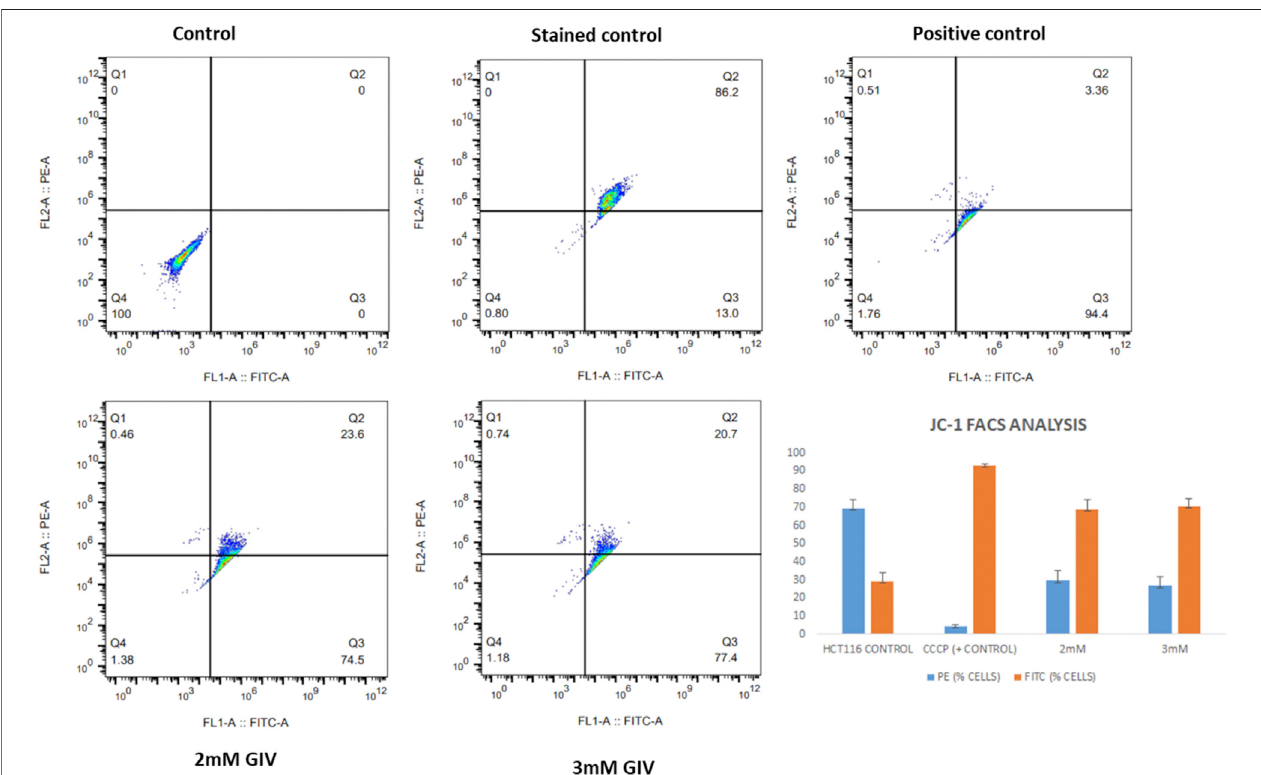
FIGURE 4 | HCT116 cells treated with GIV and analyzed for loss of MMP by fl ow cytometry using JC-1 staining. PE and FITC-positive cells under different experimental conditions are represented in the bar diagram.